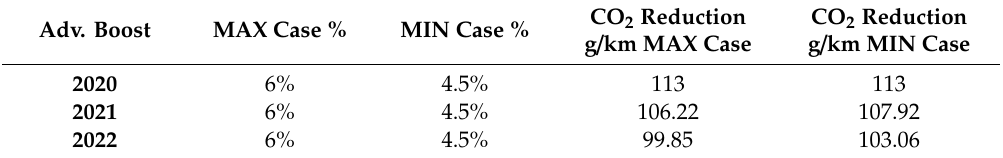
Table 4. CO 2 Reduction in Advanced Boosting Technology.